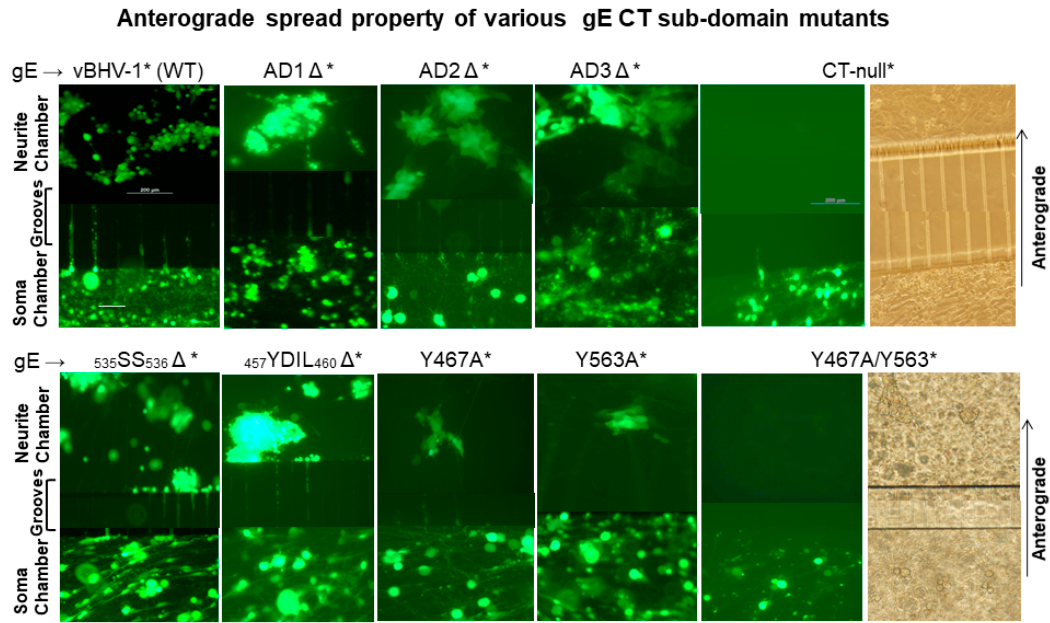
Figure 2. Anterograde spread of BHV-1 wt and various gE CT mutant viruses in compartmentalized primary neuronal culture. DRG neurons seeded in the soma compartment of microfluidic chambers were allowed to grow for two weeks, by which time the axons extended across the grooves to the neurite chamber and formed an extensive network there. MDBK cells were plated in the neurite chamber two days before the virus infection of the neurons in the soma chamber. Reconstituted BAC containing (*) vBHV-1WT*, gE CT-null*, gE ∆ AD1*, gE ∆ AD2*, gE ∆ AD3*, gE 535 SS 536* , gE ∆ 457 YDIL 460 *, gE Y467A, gE Y563A, and gE Y467A / Y563A viruses at an MOI of 50 (approximately 50 PFUs / neuron) were used for each virus infections. Representative fluorescent microscopic images shown were taken at 74 hpi. (Scale bar: 200 μ m).